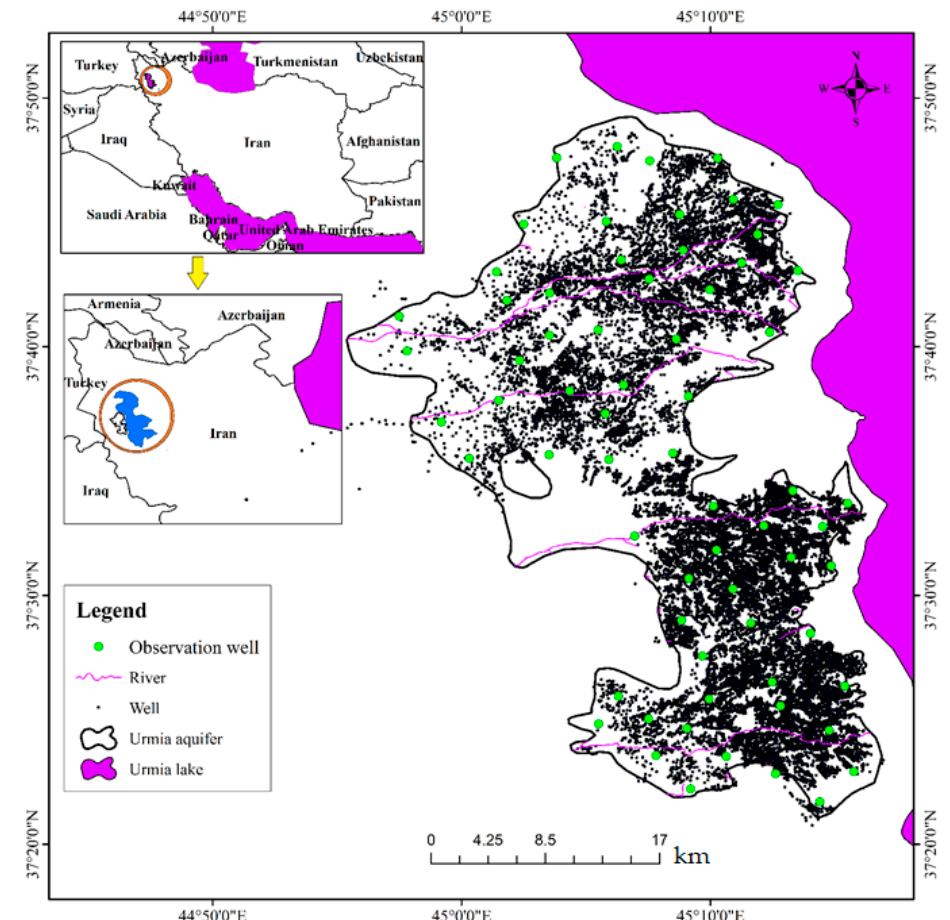
Figure 1. Location of the study area in